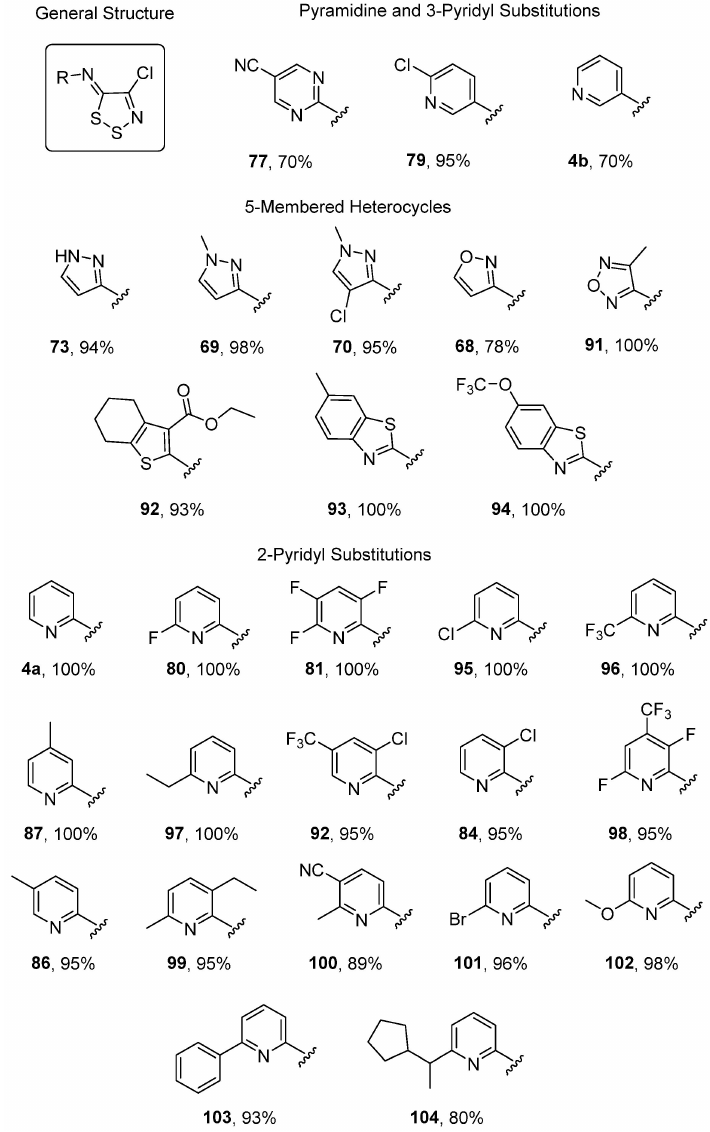
Figure 13. Sphaerotheca (cucumber) preventive; ≥ 70% efficacy at concentration of 1500